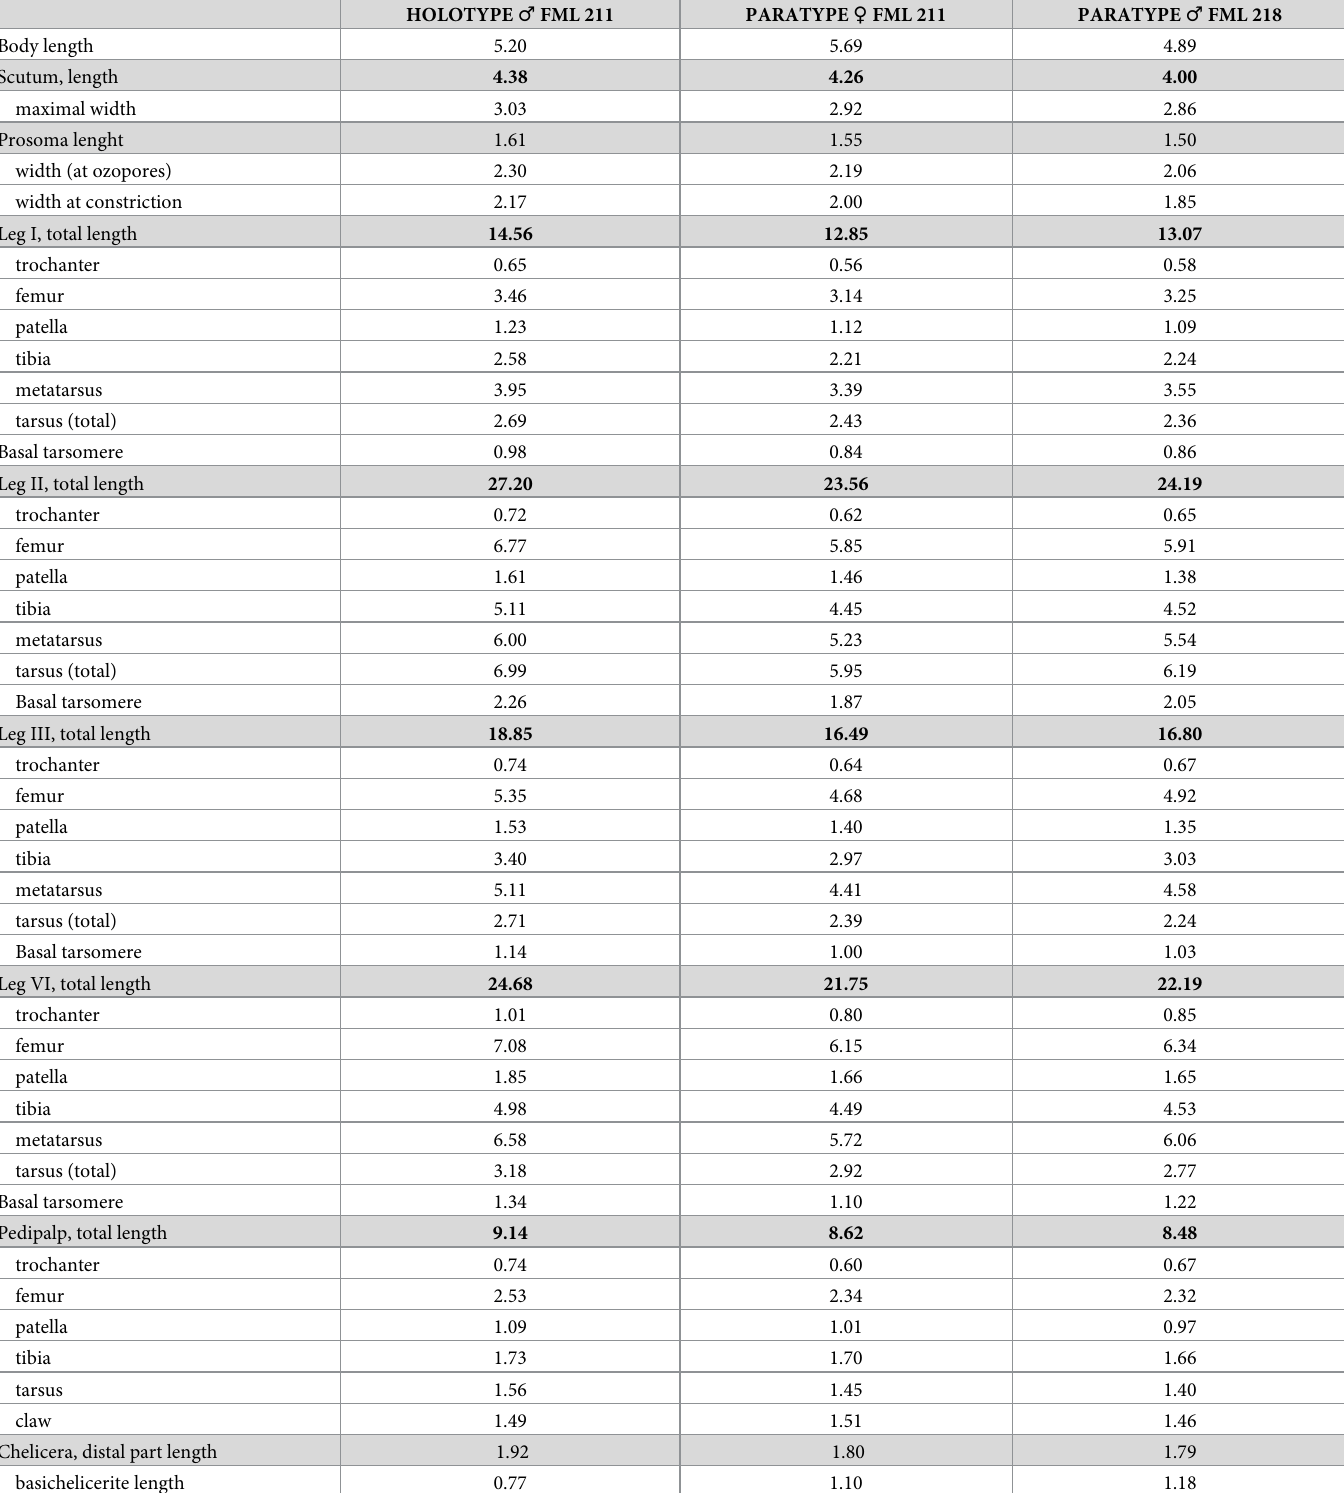
Table 4. Measurements (mm) of the holotype male, and female and male paratypes of Otilioleptes marcelae gen. nov., sp.